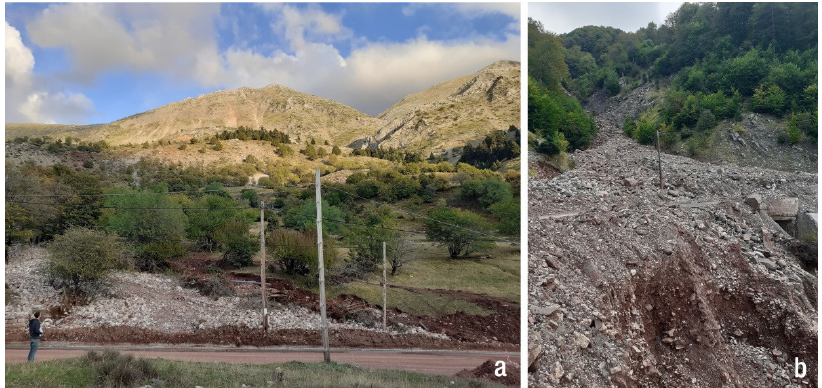
Figure 7. Characteristic rotational failures around Amarantos area. ( a ) large failure in siltstone flysch west of Itamos village and ( b ) failure in weathered flysch mantle material causing damage to the road.